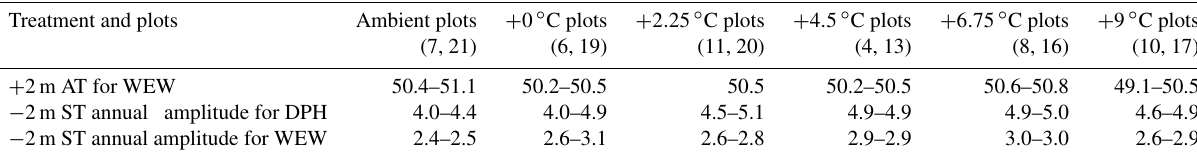
Table 3. Annual range of observed maximum minus minimum air temperature at + 2m (AT, ◦ C) for the whole-ecosystem-warming (WEW) period from August 2015 through January 2016, which includes the warmest and coldest periods of an annual cycle. Also shown is the range of maximum minus minimum soil temperatures (ST) at − 2m throughout the deep peat heating period in 2014 and 2015, and the WEW period since August